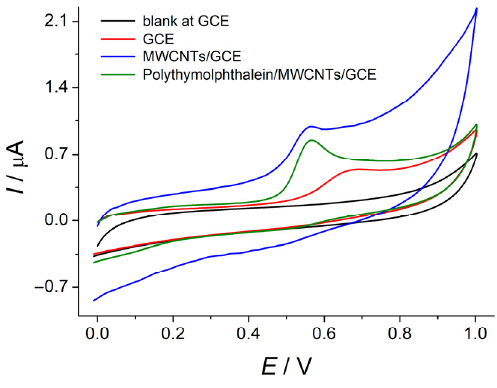
Figure 6. CVs of 10 µ M thymol at the bare GCE, MWCNTs/GCE, and polythymolph- thalein/MWCNTs/GCE in Britton–Robinson buffer pH 7.0. The potential scan rate is 100 mV s − 1 .